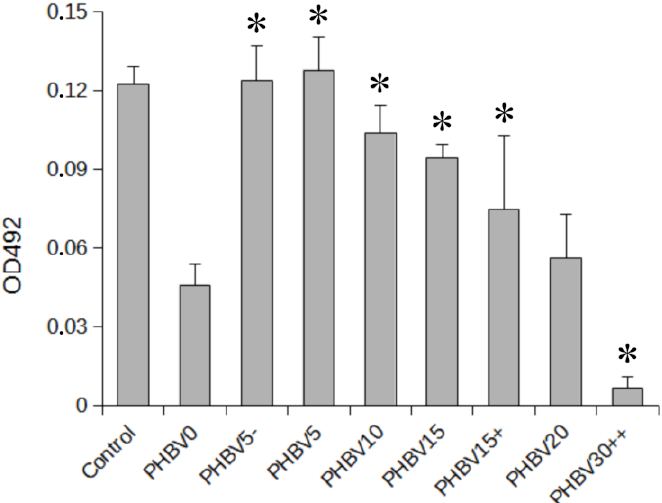
Figure 8. MTS results of SaOS ‐ 2 cells on the unmodified and LiBH 4 ‐ modified PHBV fibers after 7 days of cell seeding. An asterisk (*) indicates significant differences ( p ≤ 0.05) in optical density between the modified and non ‐ modified samples.